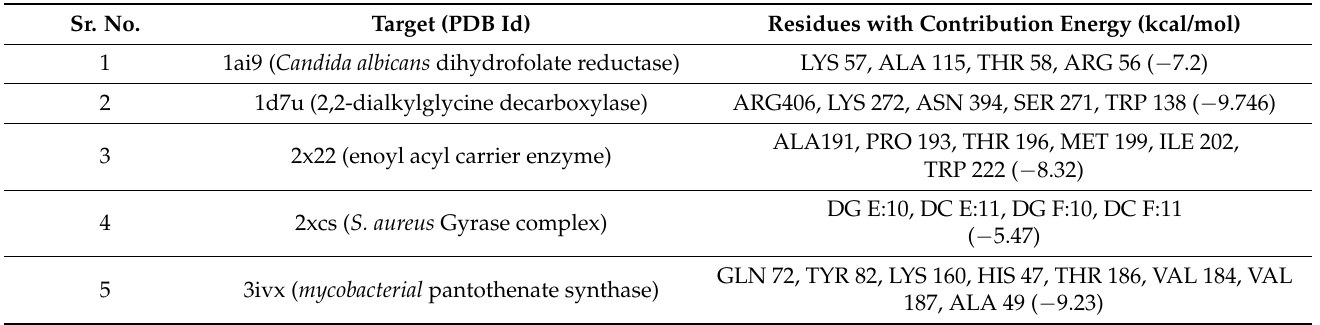
Table 1. Glide docking score for the best docked molecule, 3e , along with interacted amino acid residues against various antimicrobial